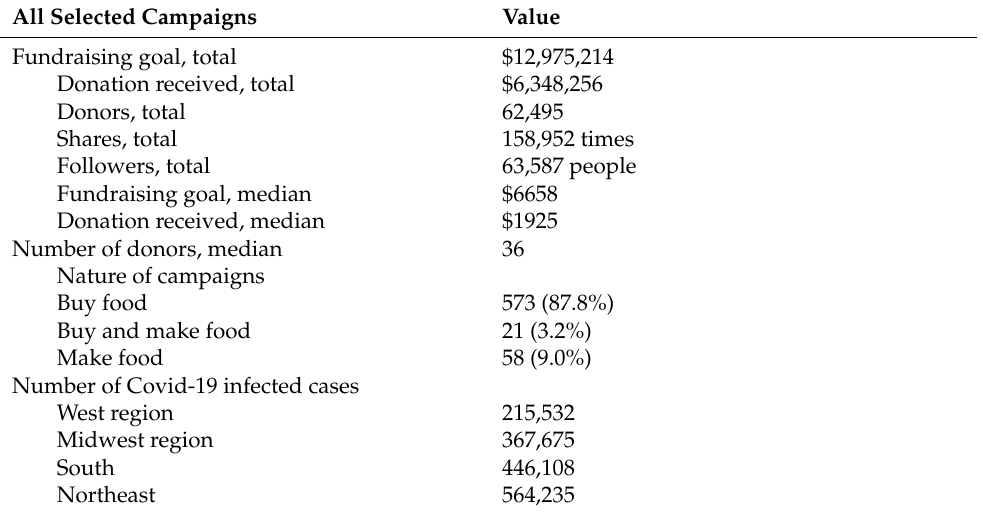
Table 1. Data characteristics of crowdfunding campaigns ( n =